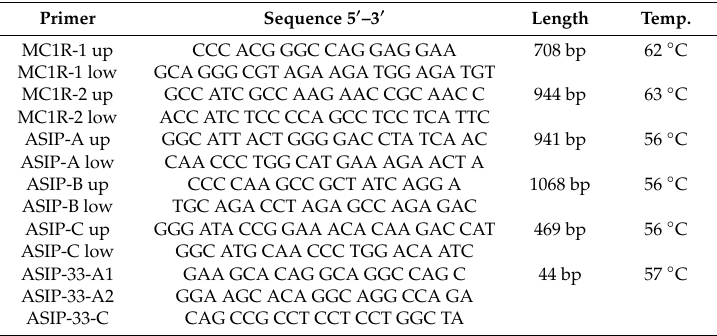
Table 1. Primers and annealing